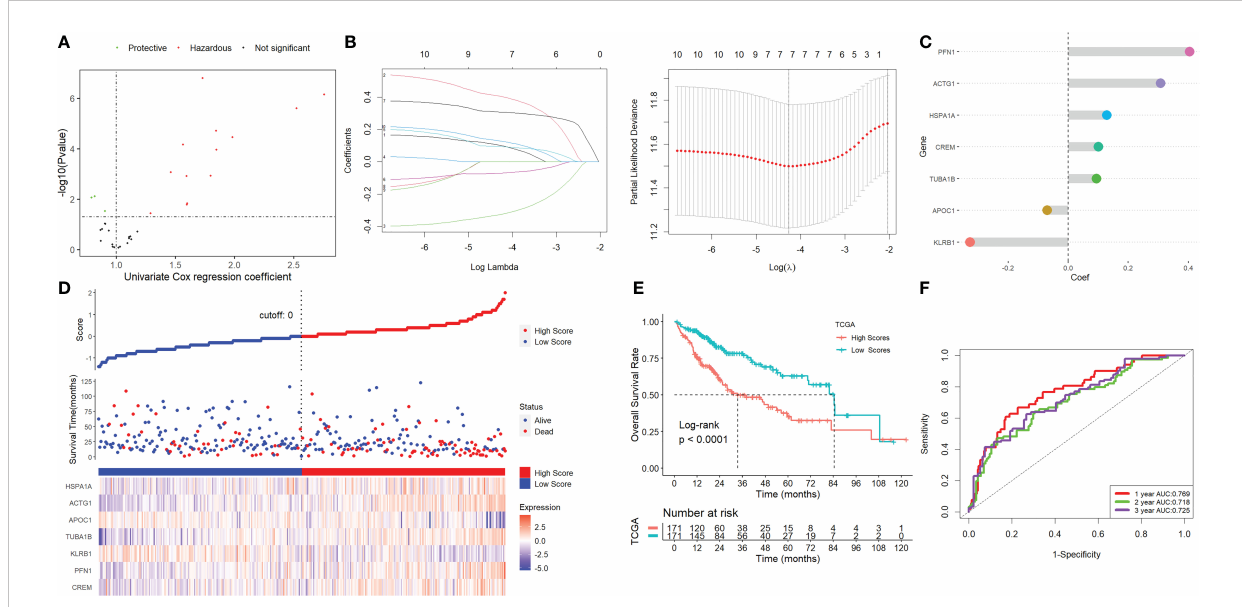
FIGURE 3 Screening for NK-associated hub genes. (A) Using univariate Cox regression analysis. (B) Lasso-Cox regression analysis. (C) Seven genes were left with a lambda value of 0.0139. (D) After each sample ’ s score was determined, the groups of high- and low-risk individuals were created. (E) Kaplan- Meier survival analysis. (F) ROC analysis.